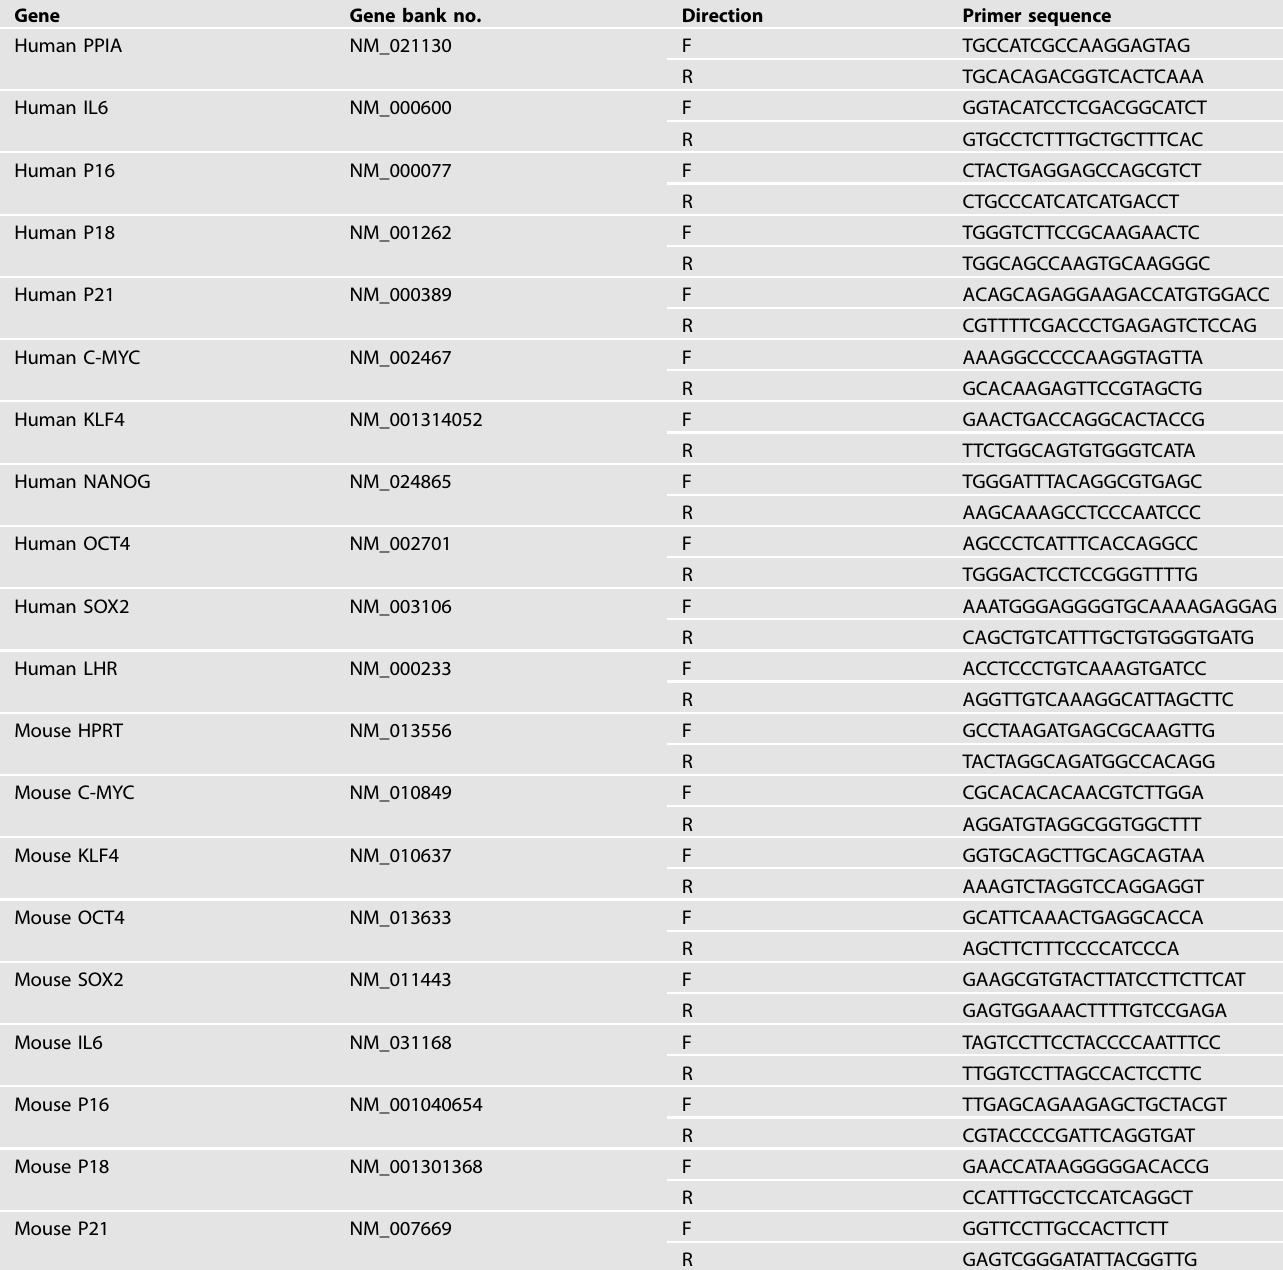
Table 1. Primer sequences for quantitative RT-PCR. Gene Gene bank